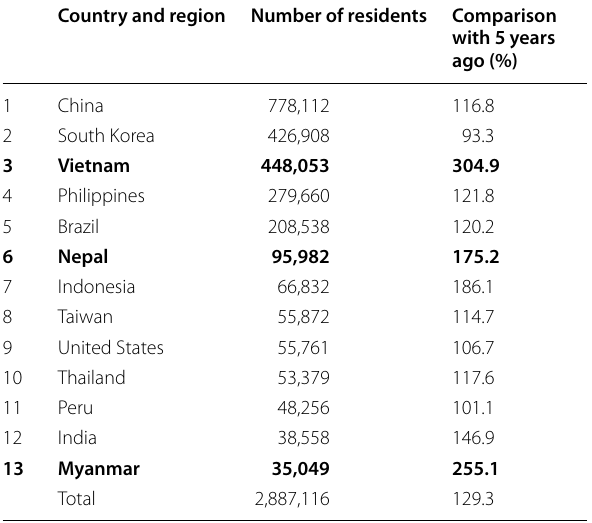
Table 1 Number of registered foreign residents in Japan by country Country and region